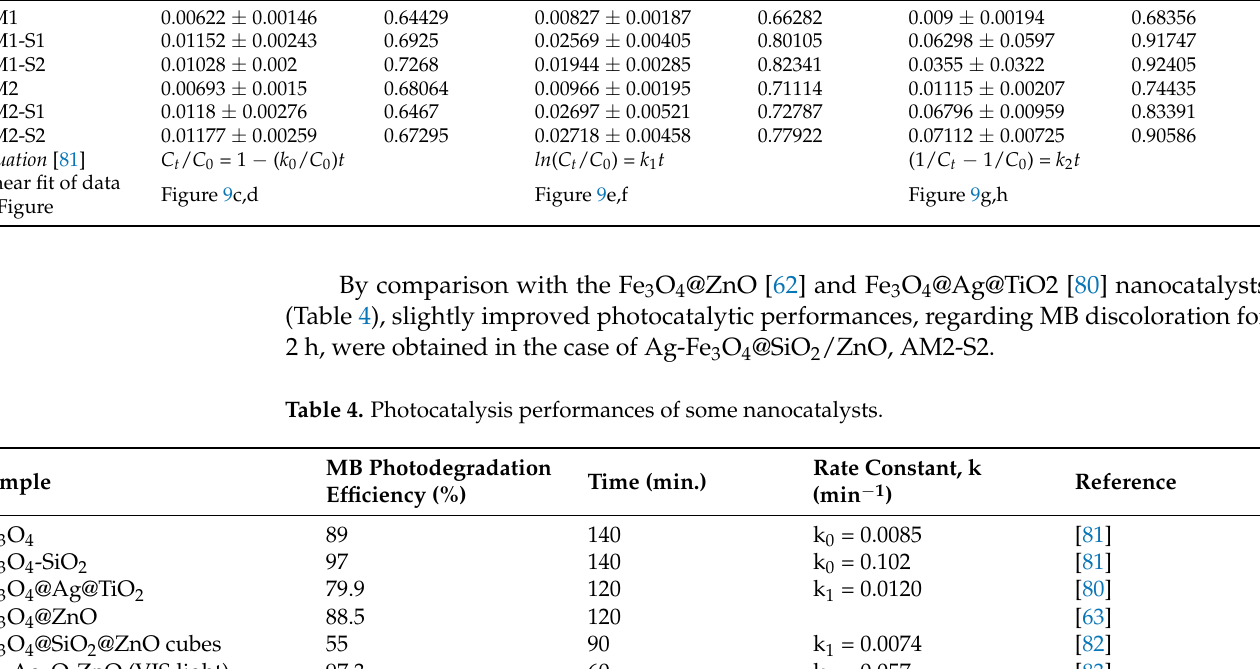
Table 3. Kinetical parameters for the 120 min. photocatalysis process of MB degradation under UV irradiation and kinetical models [81].